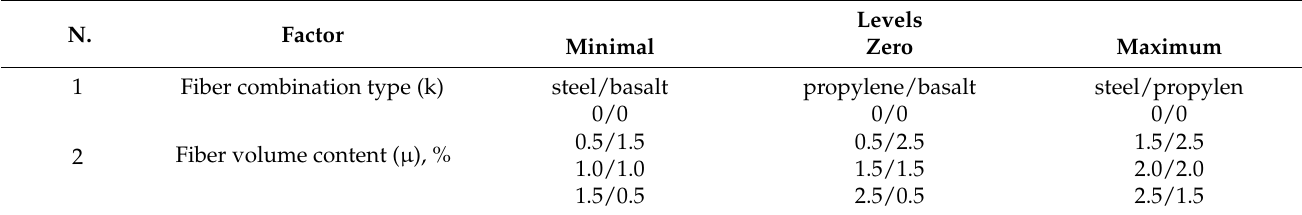
Table 7. Values varying factors.